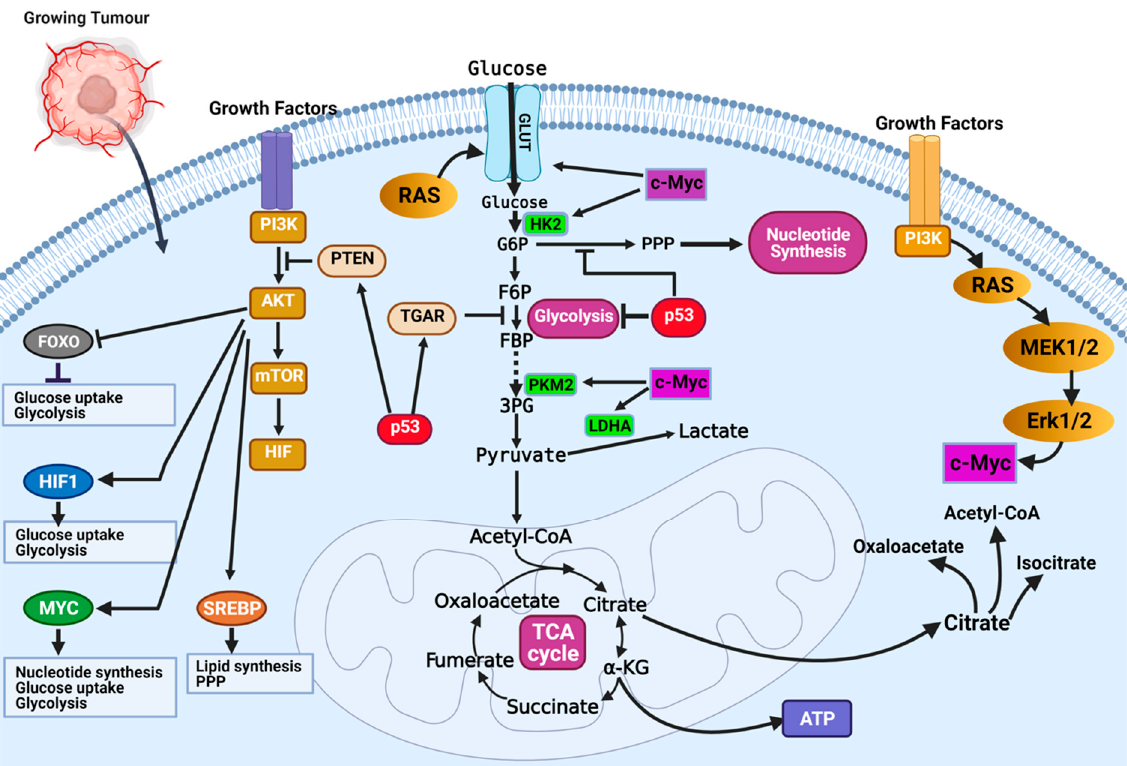
Figure 2. Mechanisms of glucose metabolic reprogramming in cancer. Hypoxia drives metabolic reprogramming in cancer cells. Increased expression of HIF transcription factors activates oncogenes (i.e., Ras, PI3K-Akt, and c-Myc) or inactivates tumor suppressors (p53 and PTEN) to sustain the glycolytic phenotype of cancer cells. Inactivation of the tumor suppressor gene TP53 is a common feature in cancers and contributes to the enhanced dependence on glycolysis. Inactivation of p53 releases repression of glucose transporters (e.g., GLUT1 and GLUT4) and decreases the expression of TIGAR, a glycolytic inhibitor. Activation of growth factor receptors activate the oncogenic PI3K/Akt pathway and activates downstream targets (FOXOs, HIF1a, c-Myc, and SREBP) that contribute to glucose metabolic reprogramming in cancer cells. Figure created using BioRender.